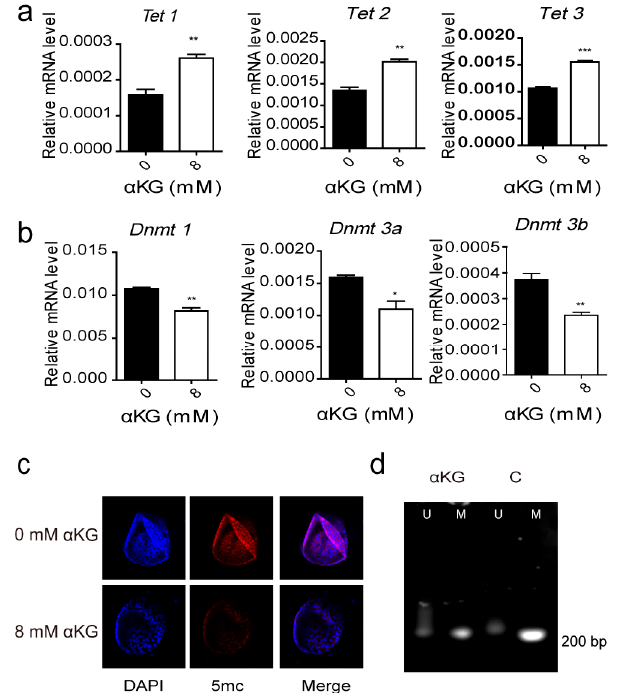
Figure 5. The detection of DNA demethylation levels in α KG treated colonies. ( a ) the expression of Tet and ( b ) Dnmt tested by Real-time PCR in the 3D cultured colonies containing 0 mM and 8 mM α KG; ( c ) the expression of 5mc in the 3D cultures with 0 mM and 8 mM α KG was observed by immunofluorescence under a laser scanning confocal microscopy; nuclei were stained with DAPI; ( d ) methylation-specific PCR (MSP) analysis of the CyclinD1 gene promoter in the 3D culture with or without α KG by PCR (U = unmethylated DNA, M = methylated DNA). Results are shown as means + SEM and represent three independent experiments. *** p < 0.001 versus 0 mM α KG group; ** p < 0.01 versus 0 mM α KG group; * p < 0.05 versus 0 mM α KG group.